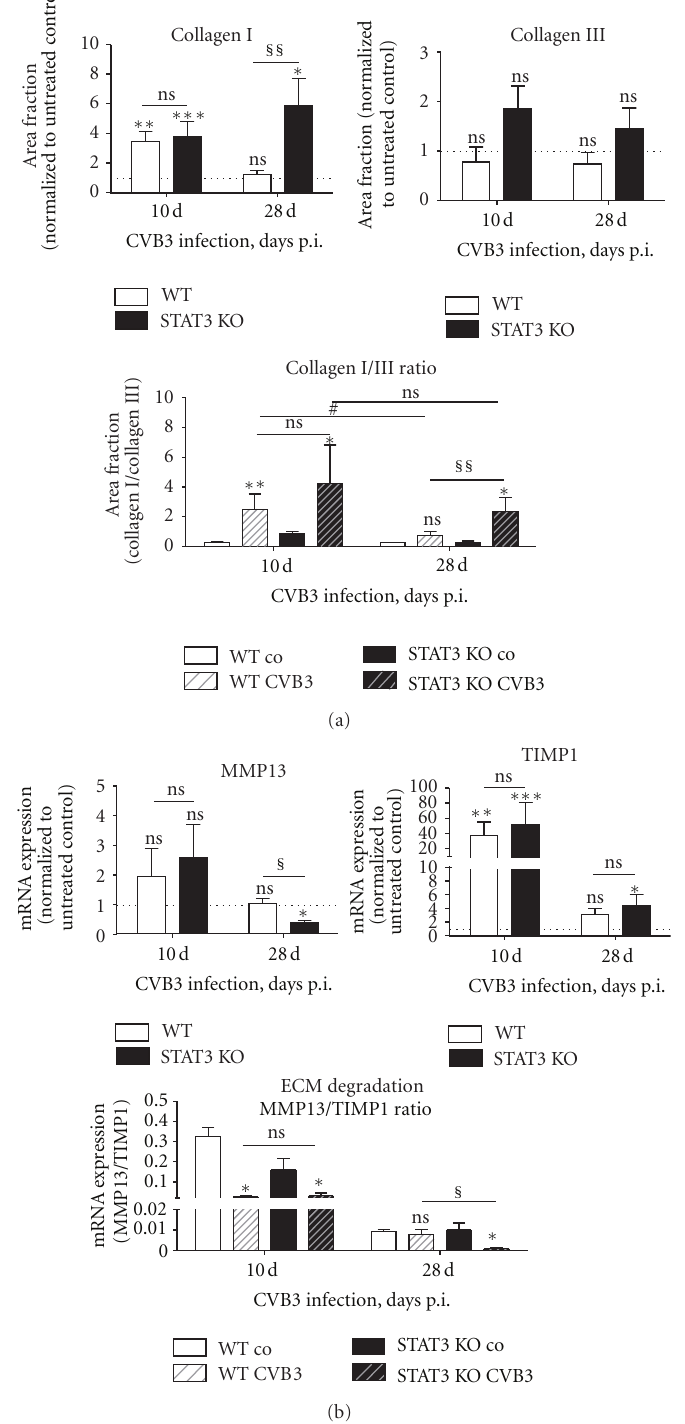
Figure 5: Collagen expression and expression of the ECM degrading system in cardiac tissue of CVB3-infected mice. The area fractions of collagen I and collagen III are shown 10 and 28 days after CVB3 infection of WT and STAT3 KO mice as x-fold compared to the corresponding untreated controls. The mRNA expression data of MMP13 and TIMP1 are normalized to the house-keeping gene 18S and to the expression levels of the corresponding untreated mice and expressed as x-fold over basal expression using the formula 2 − ΔΔ Ct . The ratios were calculated without previous normalization to the untreated controls. ∗ Data were compared to the expression of the corresponding untreated controls. ∗ P < 0 . 05; ∗∗ P < 0 . 01; ∗∗∗ P < 0 . 001. § Data between WT and STAT3 KO mice were compared. § P < 0 . 05; §§ P < 0 . 01. # Data between 10 or 28 days were compared. # P < 0 .